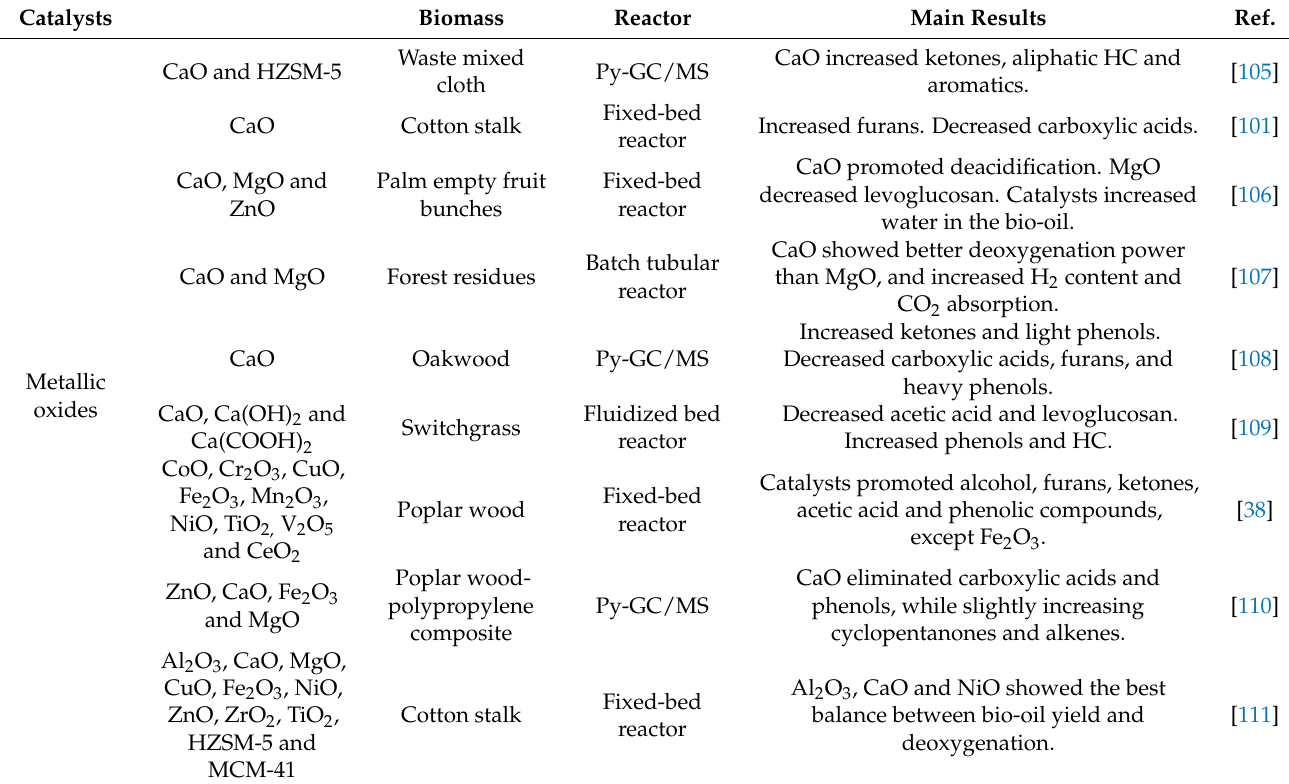
Table 2. Some examples of metal oxide and metal salt catalysts for biomass